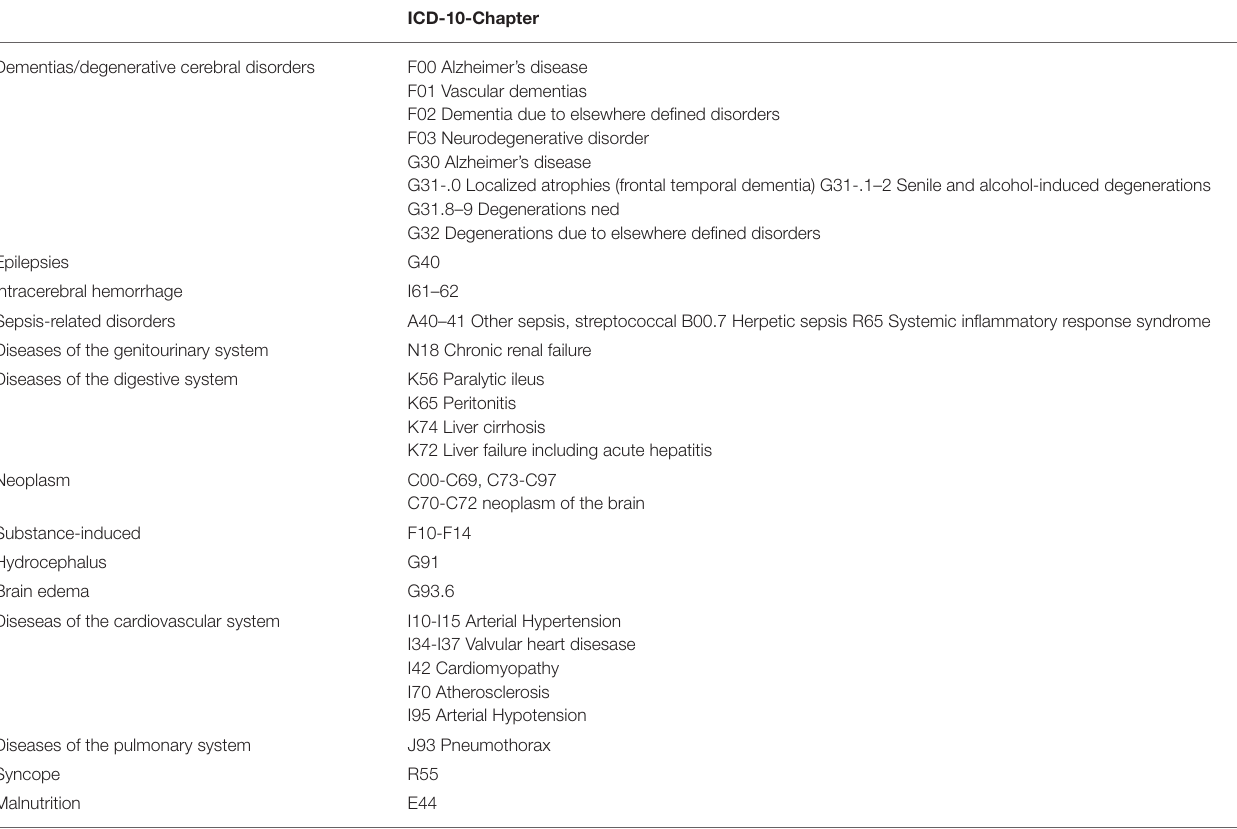
TABLE 1 | HDiagnostic clusters with their respective included diagnoses according to the International Statistical Classifications of Diseases and Related Health Problems 10th Revision